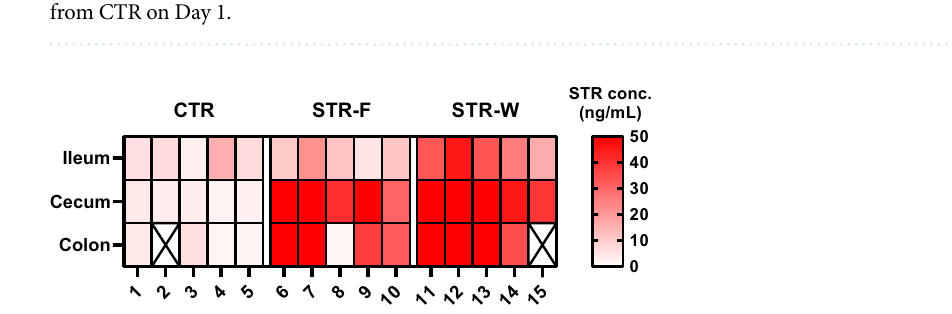
Figure 2. CFU counts. ( a ) E. coli CFU counts per gram of fecal material at Day 1, Day 2, and Day 3; ( b ) E. coli CFU counts per gram of cecum content at Day 1, Day 2, and Day 3; ( c ) E. coli CFU counts per gram of colon content at Day 1, Day 2, and Day 3. *( P < 0.05); **( P < 0.01); *** ( P < 0.001). Only four samples were obtained from CTR on Day 1.